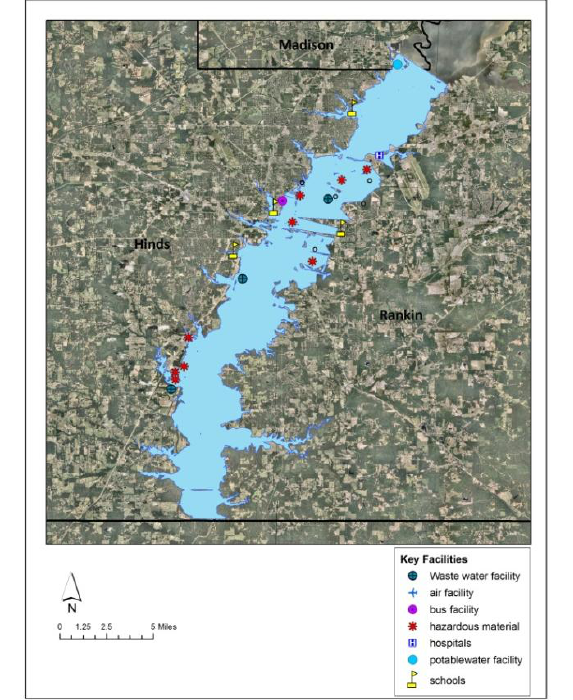
Figure 21. Spatial locations of affected key facilities downstream of Ross Barnett Reservoir.